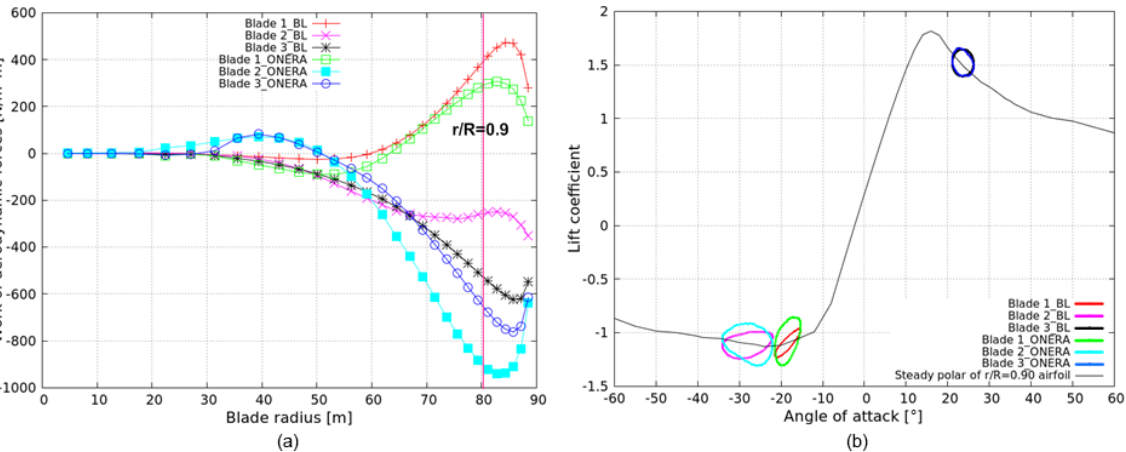
Figure 29. Distribution of aerodynamic work over the three blades for mode M7. Azimuth angle 100 ◦ . (b) C L –AOA loops of the three blades at r/R = 0 . 90 for mode M7. Azimuth angle 100 ◦